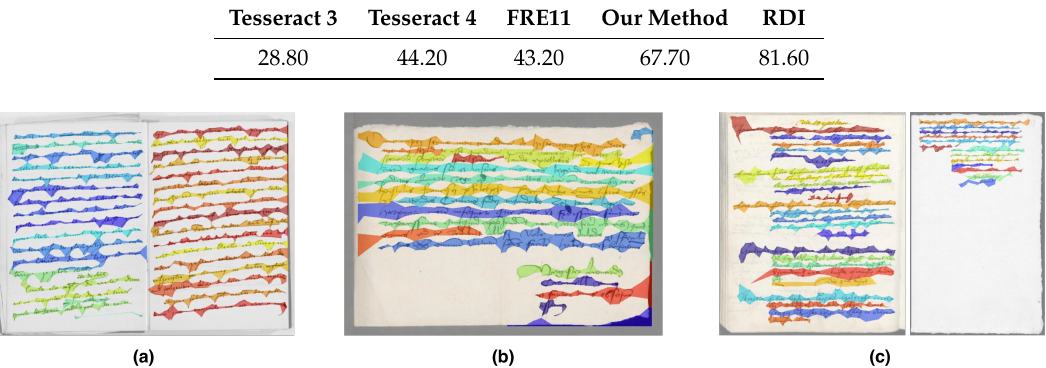
Figure 12. Example results from cBAD dataset. Slightly skewed text lines can be extracted ( a ). Common error cases arise from group of touching characters among two different text lines but that have relatively big gap with their neighbours in the same text line ( b ). Text lines with heterogeneous lengths can be extracted ( c ).